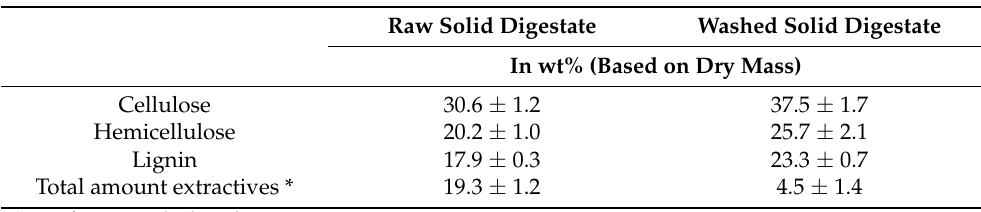
Table 1. Composition of raw and washed fibrous digestate, including the mean values and standard deviations calculated from duplicates.